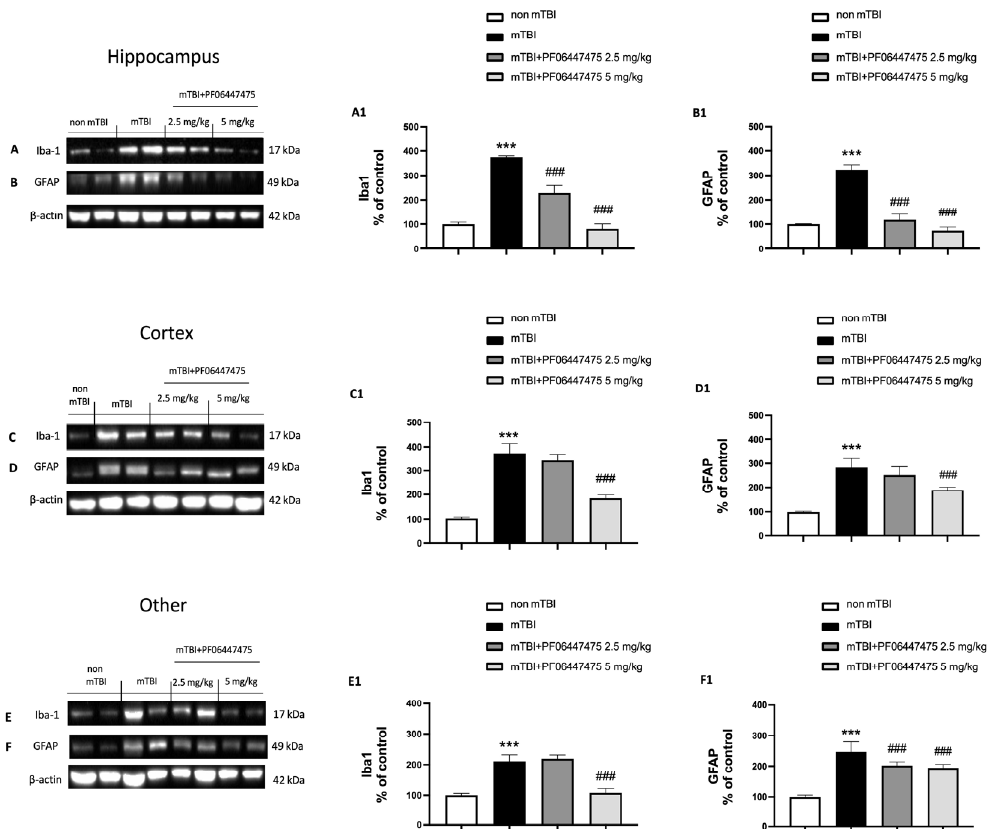
Figure 4. Effects of PF-475 on astrocytes and microglia activation after mTBI in hippocampus, cortex and other. Cytosolic fractions of hippocampus tissue were used to evaluate astrocytes and microglia activation trough the expression of GFAP and Iba-1, respectively. Representative blot of Iba-1 is shown ( A ), see densitometric analysis ( A1 ); representative blot of GFAP is shown ( B ), see densitometric analysis ( B1 ). Cytosolic fractions of cortex tissue: representative blot of Iba-1 is shown ( C ), see densitometric analysis ( C1 ); representative blot of GFAP is shown ( D ), see densitometric analysis ( D1 ). Cytosolic fractions of other tissue: representative blot of Iba-1 is shown ( E ), see densitometric analysis ( E1 ); representative blot of GFAP is shown ( F ), see densitometric analysis ( F1 ). Two-way ANOVA test. *** p < 0.001 vs. non mTBI; ### p < 0.001 vs.